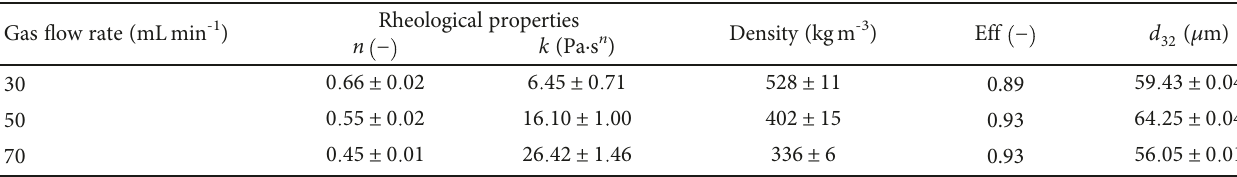
CS: chitosan;WPI:wheyproteinisolate;HAp: hydroxyapatite; n : fl owbehaviour index; k : consistencyindex; Eff : foaminge ffi cacy; d 32 : bubblesize; L : liquid fl ow rate; N : rotating speed. Each assay was done in triplicate, and data are expressed as means ( ± standard